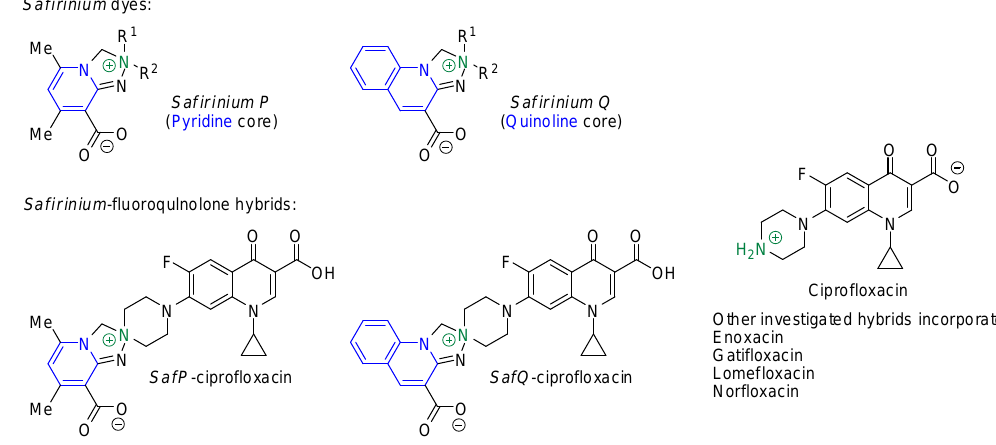
Figure 1. General structures of Safirinium dyes and their hybrids exemplified by ciprofloxacin, SafP – ciprofloxacin and SafQ –ciprofloxacin